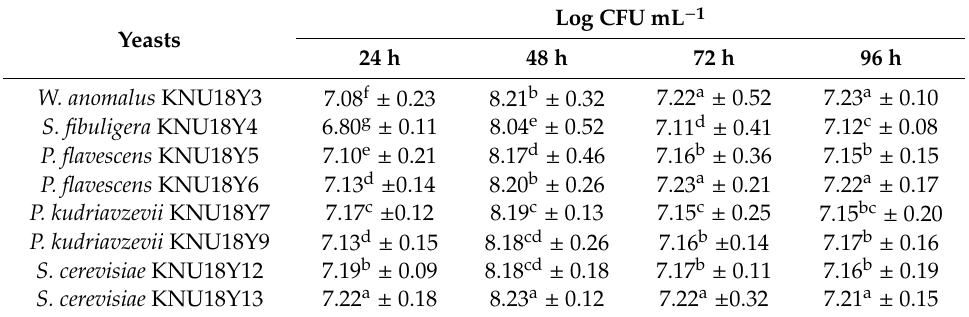
Table 5. The living cells of yeast species at di ff erent fermentation hours (24, 48, 72, and 96) in CPM.